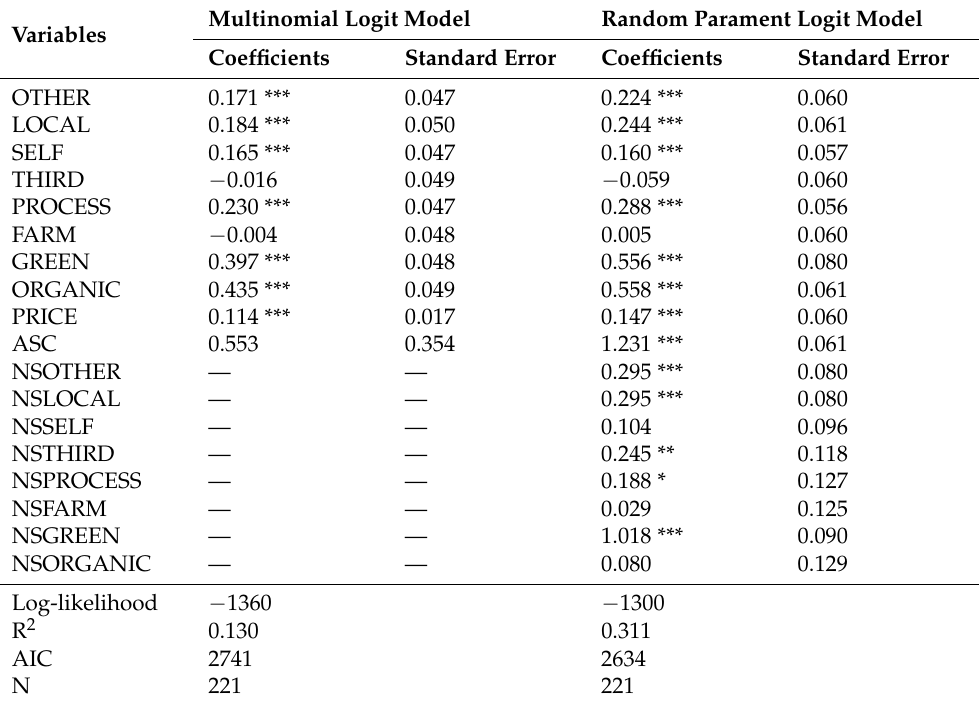
Table 3. Famers’ preference for different food safety information